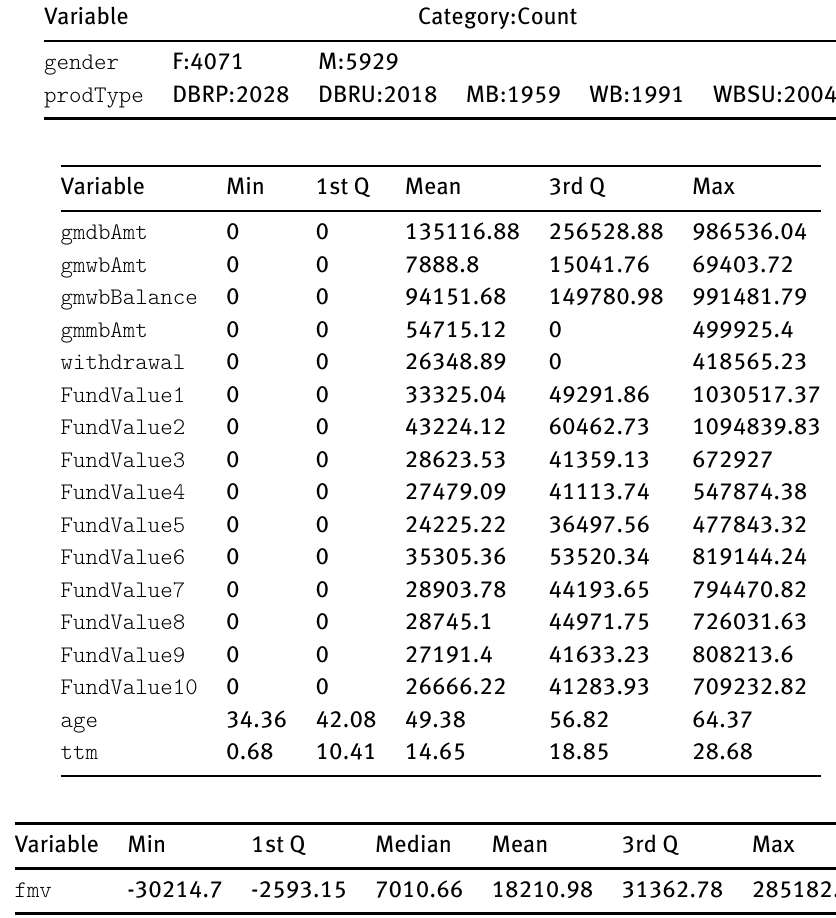
Table 1: Summary statistics of the explanatory variables and the dependent variable for the GB2 regression